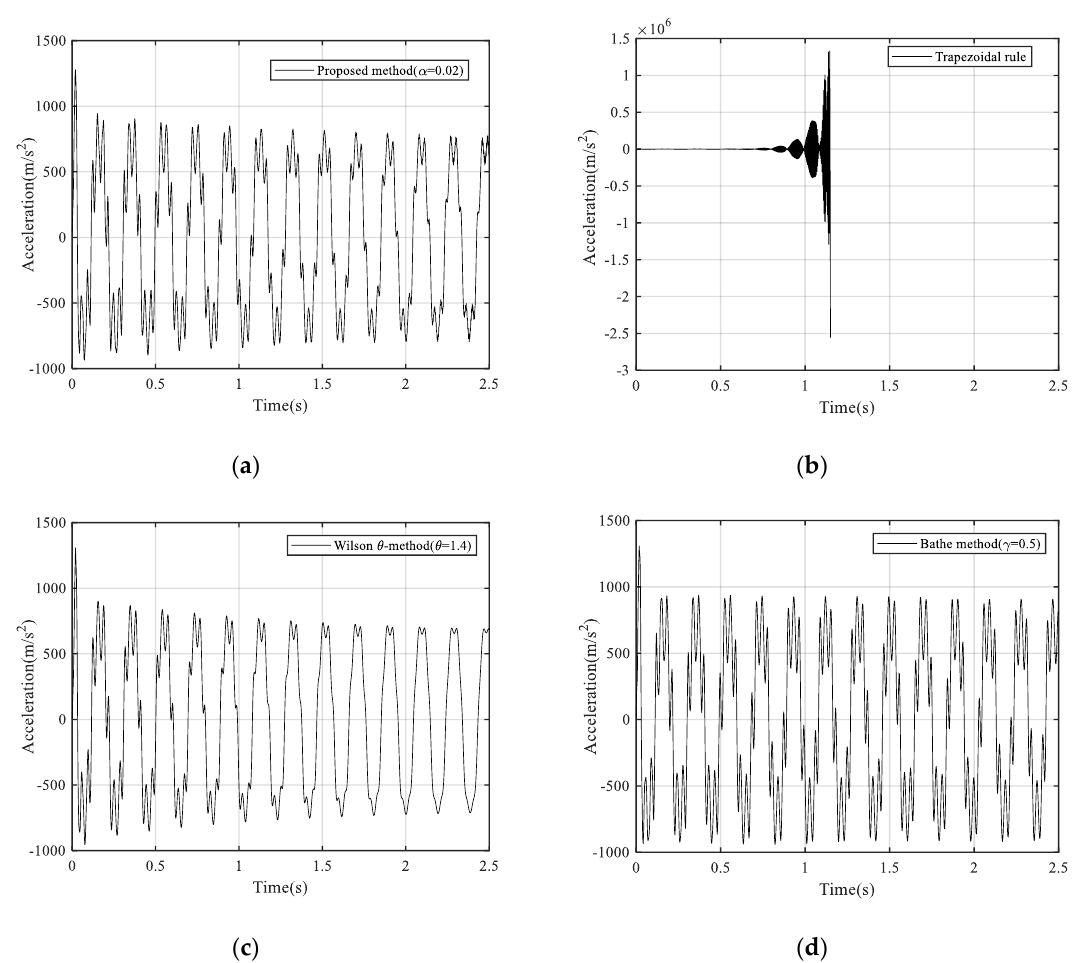
Figure 22. The acceleration responses at the free end of the cantilever beam: ( a ) Using the proposed method, ( b ) using the trapezoidal rule, ( c ) using Wilson θ -method, and ( d ) using Bathe method.